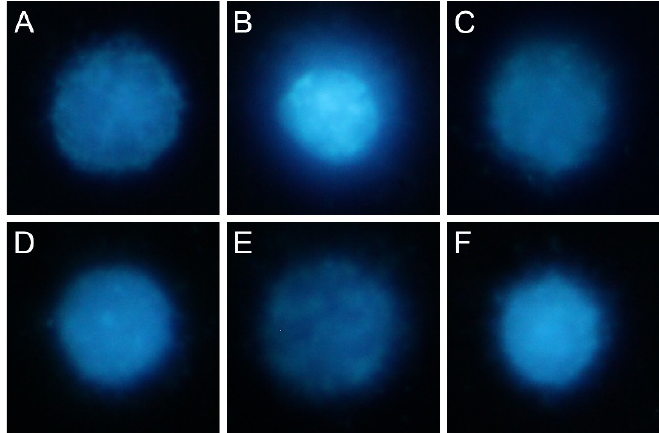
Figure 7. Microphotographs of a nuclear halo: ( A ) sample cell incubated without LPS and without compounds (negative control); ( B ) sample cell incubated only with LPS; ( C ) sample cell incubated with LPS and compound 2a (10 µ M); ( D ) LPS and compound 2b (10 µ M); ( E ) LPS and compound 3a (10 µ M); ( F ) LPS and compound 3b (10 µ M).